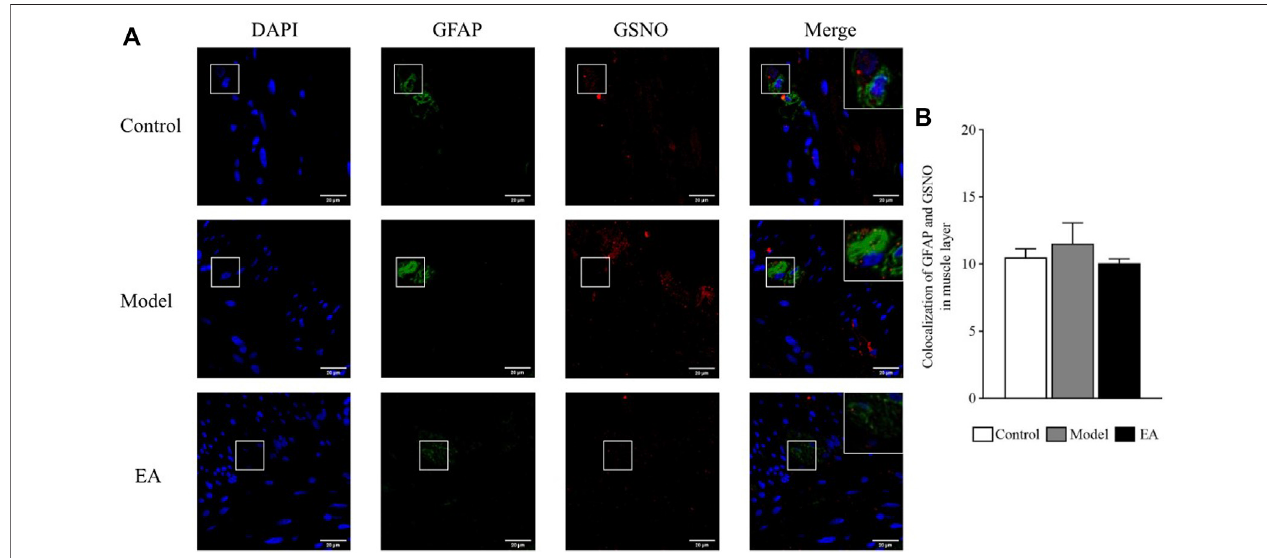
FIGURE 7 | Colocalized GFAP and GSNO expressions in the muscle layer. GFAP and GSNO fl uorescence in different groups (A) ; green indicates GFAP, red indicatesGSNO,andblueindicatesDAPI-stainednucleus.One-wayANOVAindicatedthatthecolocalizationofGFAPandGSNOwasnotstatisticallydifferentindifferent groups (B) . Scale bar = 20 μ m, bar: mean ± SE, n =